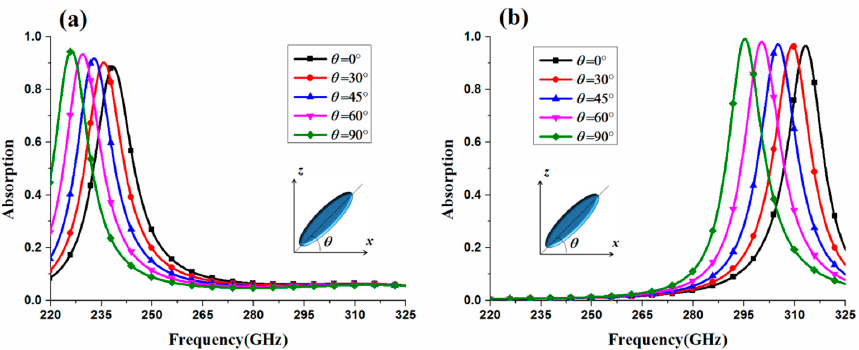
Figure 3. Simulated absorption spectra of absorber for different LC director angles for ( a ) the TE-polarized incident wave and ( b ) the TM-polarized incident wave.